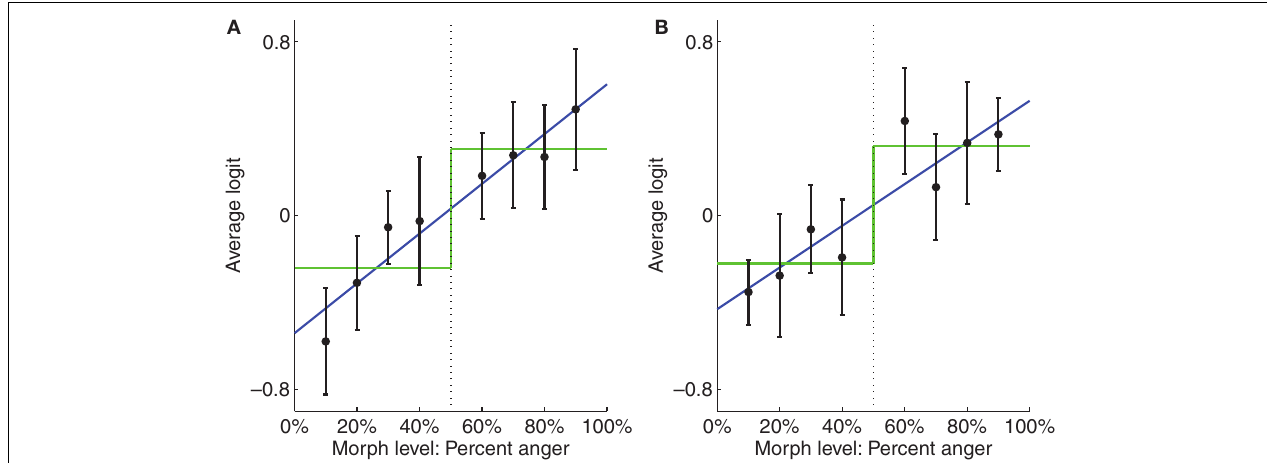
FIGURE 6 | Plots of average SMLR-based logit, which is used as a measure of neural representation against morph level. Low logit values indicate the brain pattern is close to the fear representation. High logit values indicate it is close to the anger representation. Best fi t linear and step functions are shown in blue and green, respectively. Error bars are standard error of the mean across subjects. Throughout this report, k% anger implicitly means (100-k)% fear. (A) Left STS. (B) Right STS.